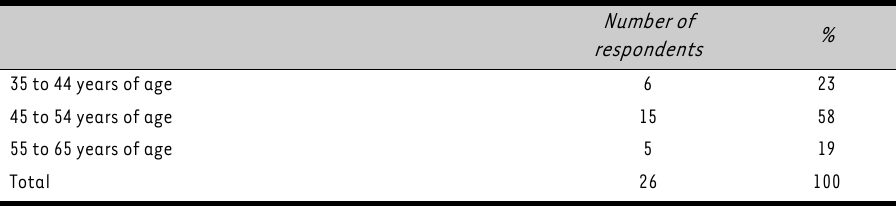
Age profile of respondents